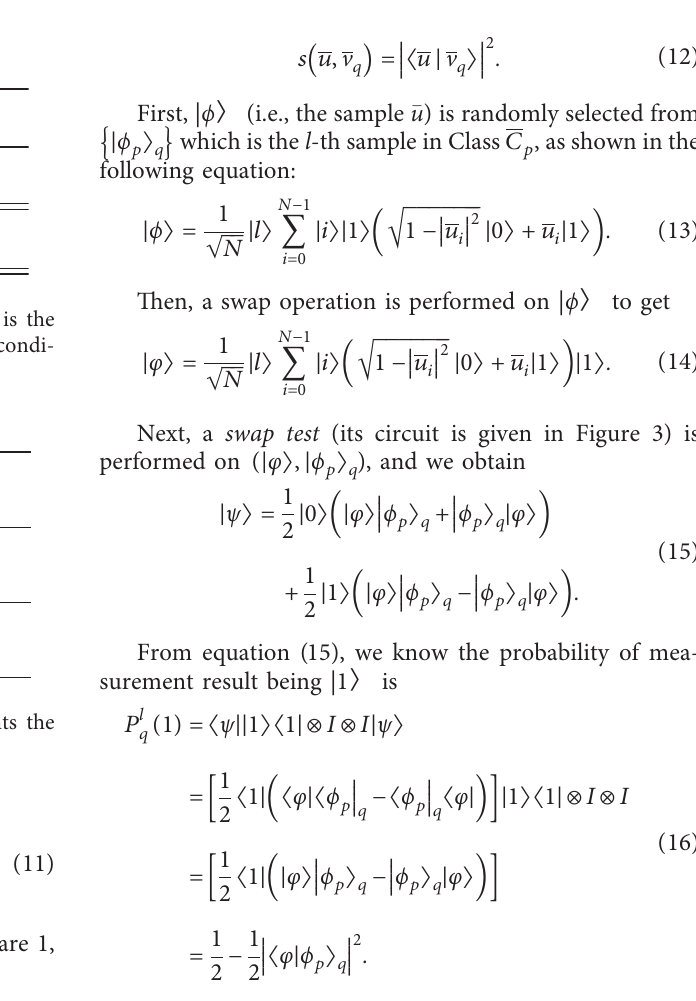
A LGORITHM 2: Quantum ReliefF algorithm.